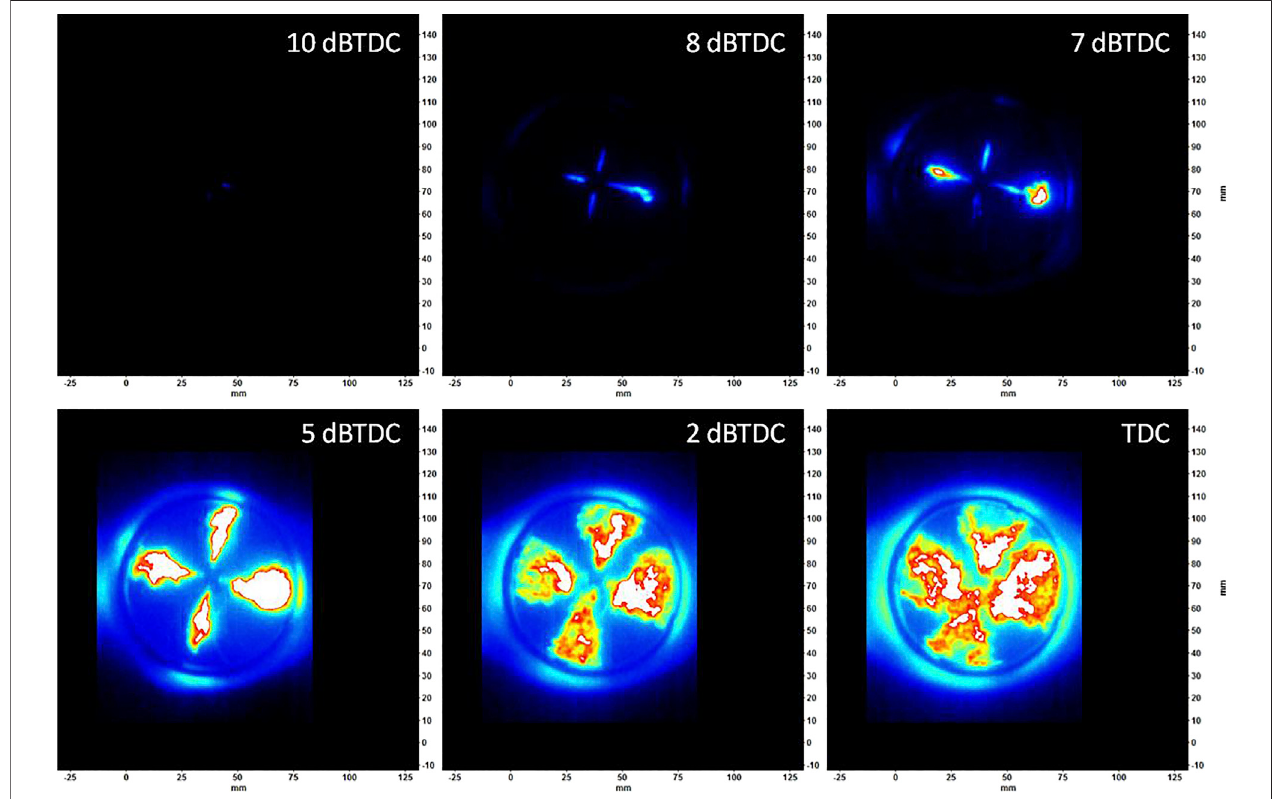
FIGURE 2 | Chemiluminescence high speed images of the jet ignition process (Speed: 1,500 rpm, gross indicated mean ef fi ective pressure (IMEPg): 5.5 bar, lambda (cid:1) 1.2) taken from an optically accessible engine. See Bunce et al., (2014) for more details of this study.